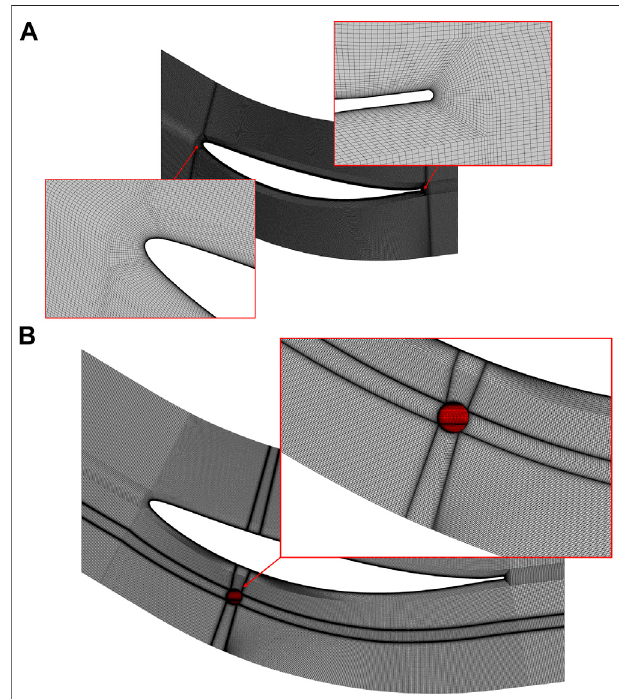
FIGURE3| Gridschemeforthebaseline,CS,andPScon fi gurations. (A) Baseline. (B) CS and